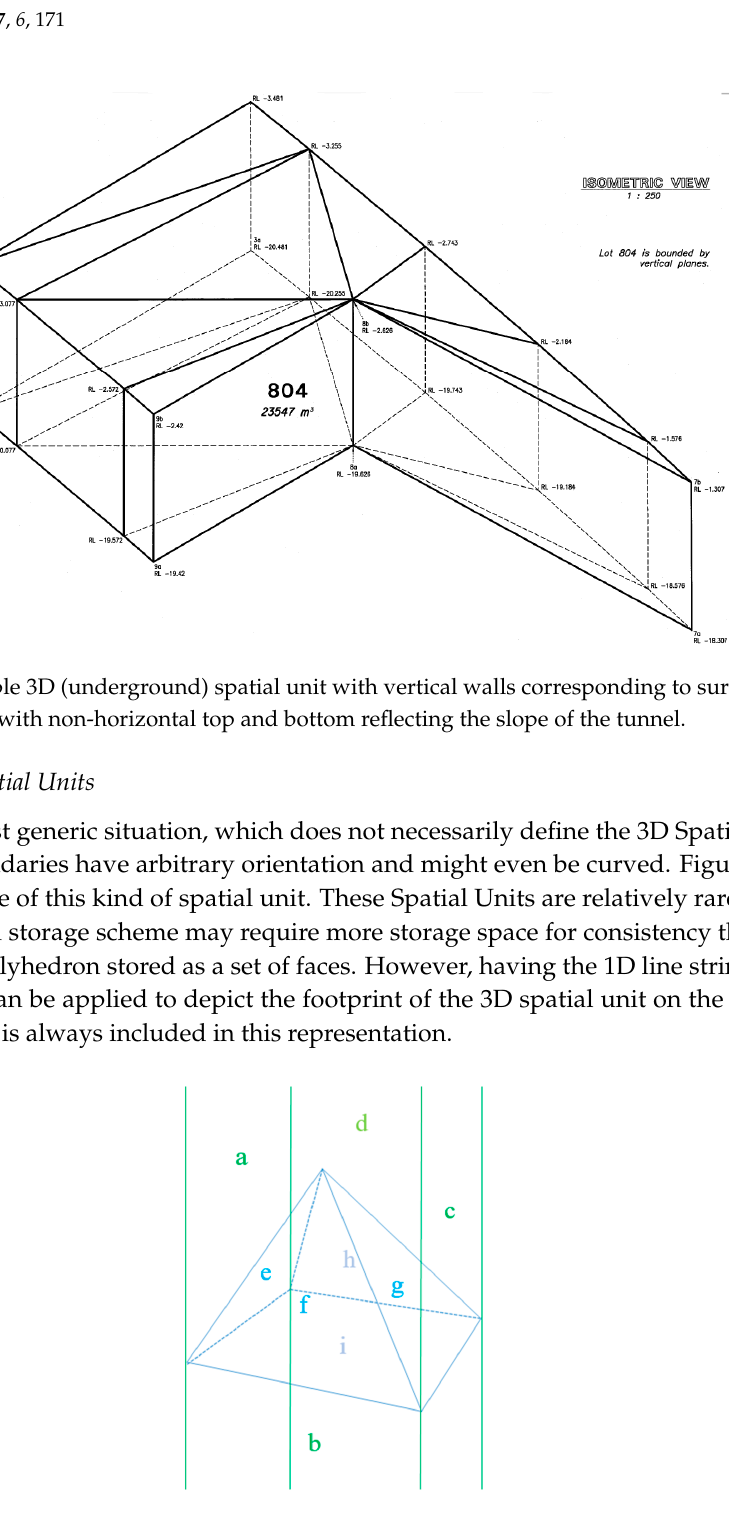
Figure 4. Complex spatial unit in the shape of a pyramid.